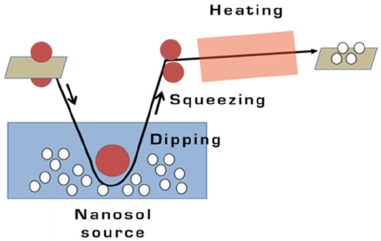
Figure 1. Schematic representation of the dip-pad-dry-cure method.